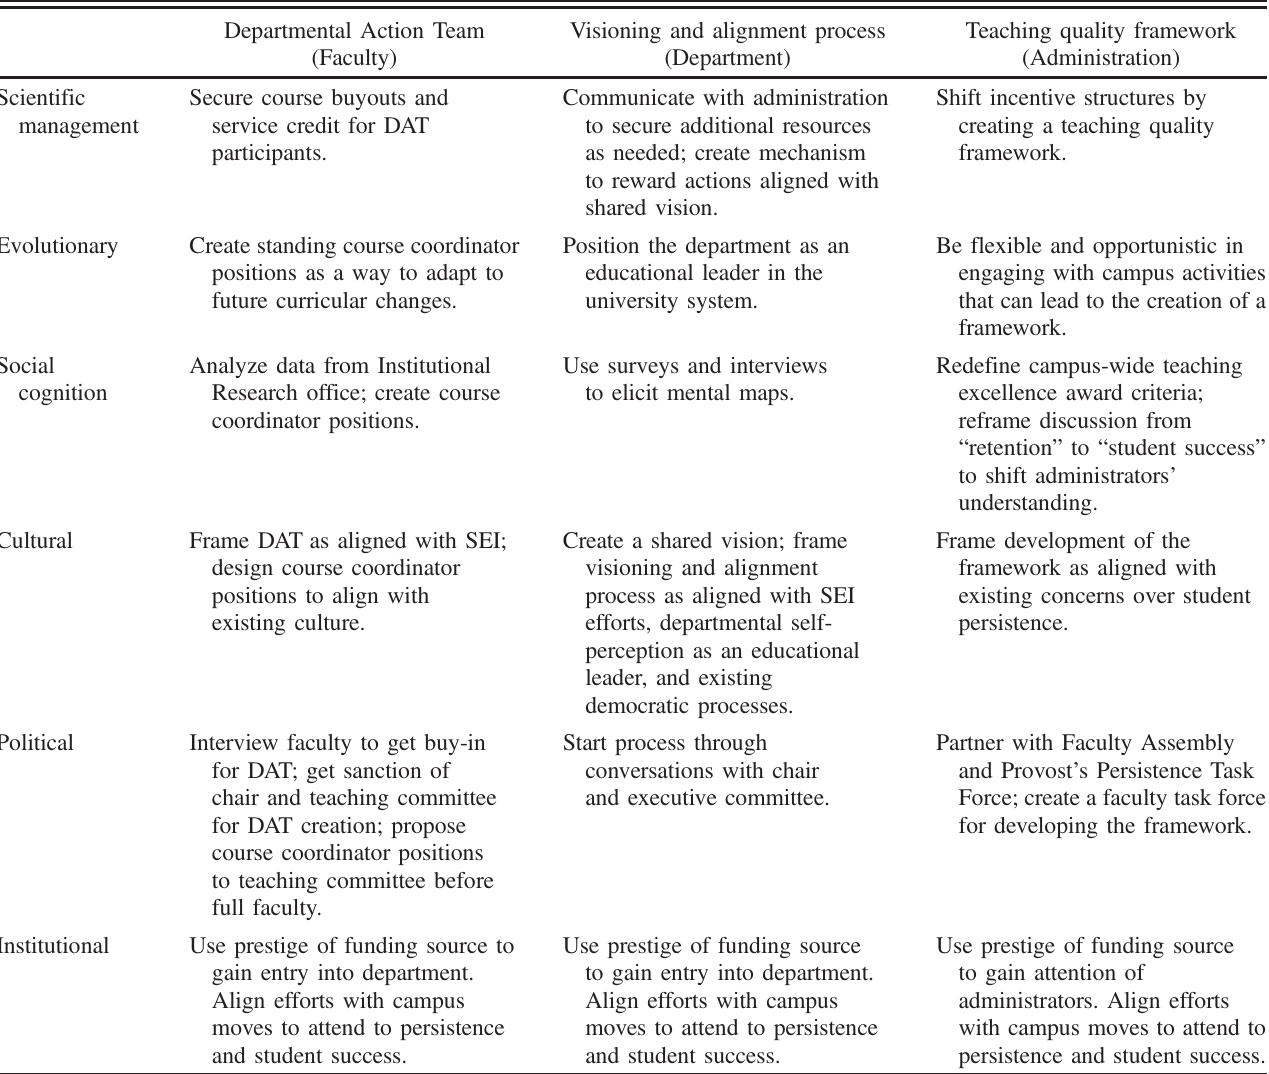
TABLE III. Summary of the ways in which the change perspectives influenced the design of our activities. Different activities at other institutions will be shaped by the change perspectives in different ways, based on local